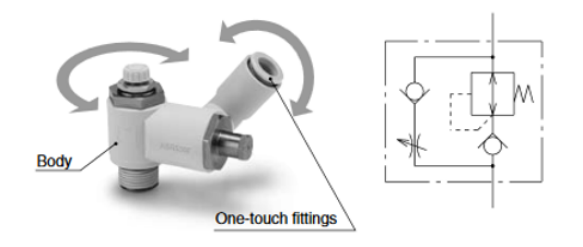
Fig. 2. ASR air saving pressure regulator valve SMC [4]